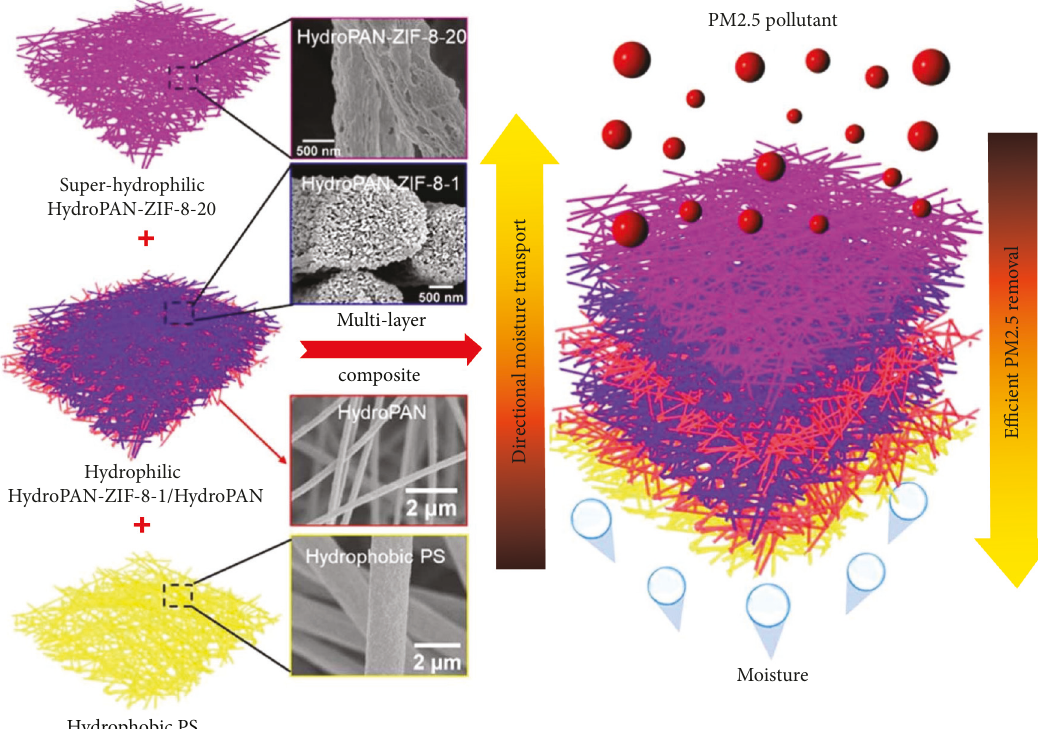
Figure 8: Schematic diagram for multilayer electrospun nanofibers [65].